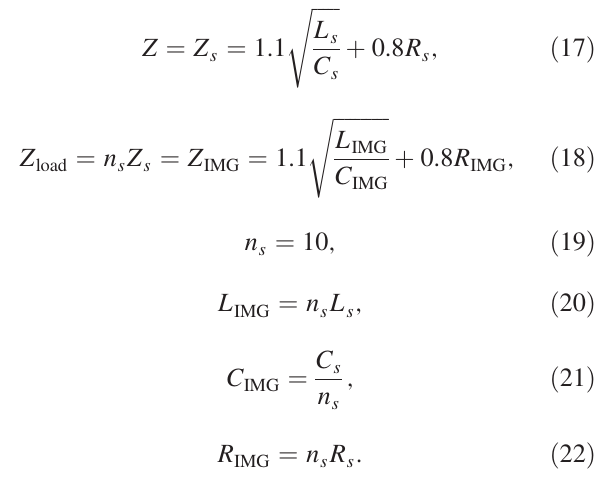
Figure 5(a) models the coaxial line that is driven by the IMG as ten transmission-line segments. This figure assumes that the impedance of the n th segment is nZ , where Z is the impedance of the first segment. The transmission line drives a load with impedance Z line segments are lossless, the impedance of each section is nonreactive and constant throughout its length, and the load impedance is purely resistive (i.e., nonreactive).